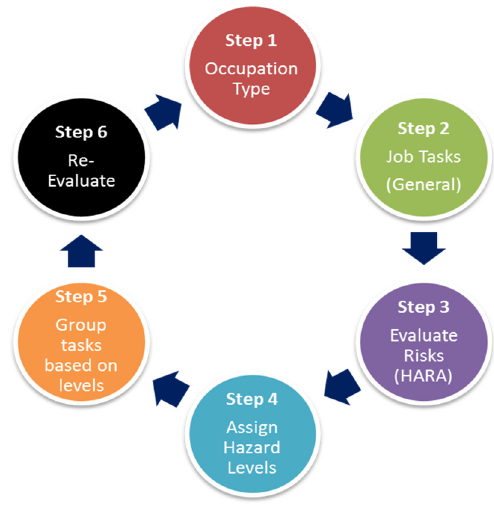
Figure 6. Process of performing a JSA in student team.